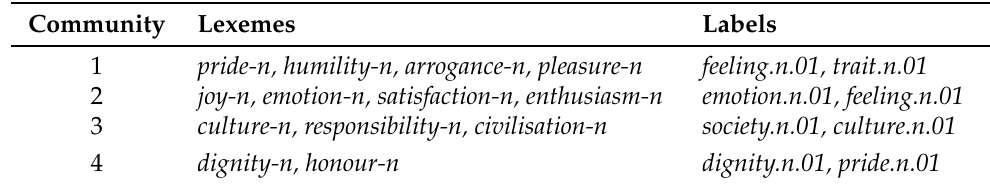
Table 2. Labels of semantic communities in lexical dependency graph of lexeme pride-n calculated on